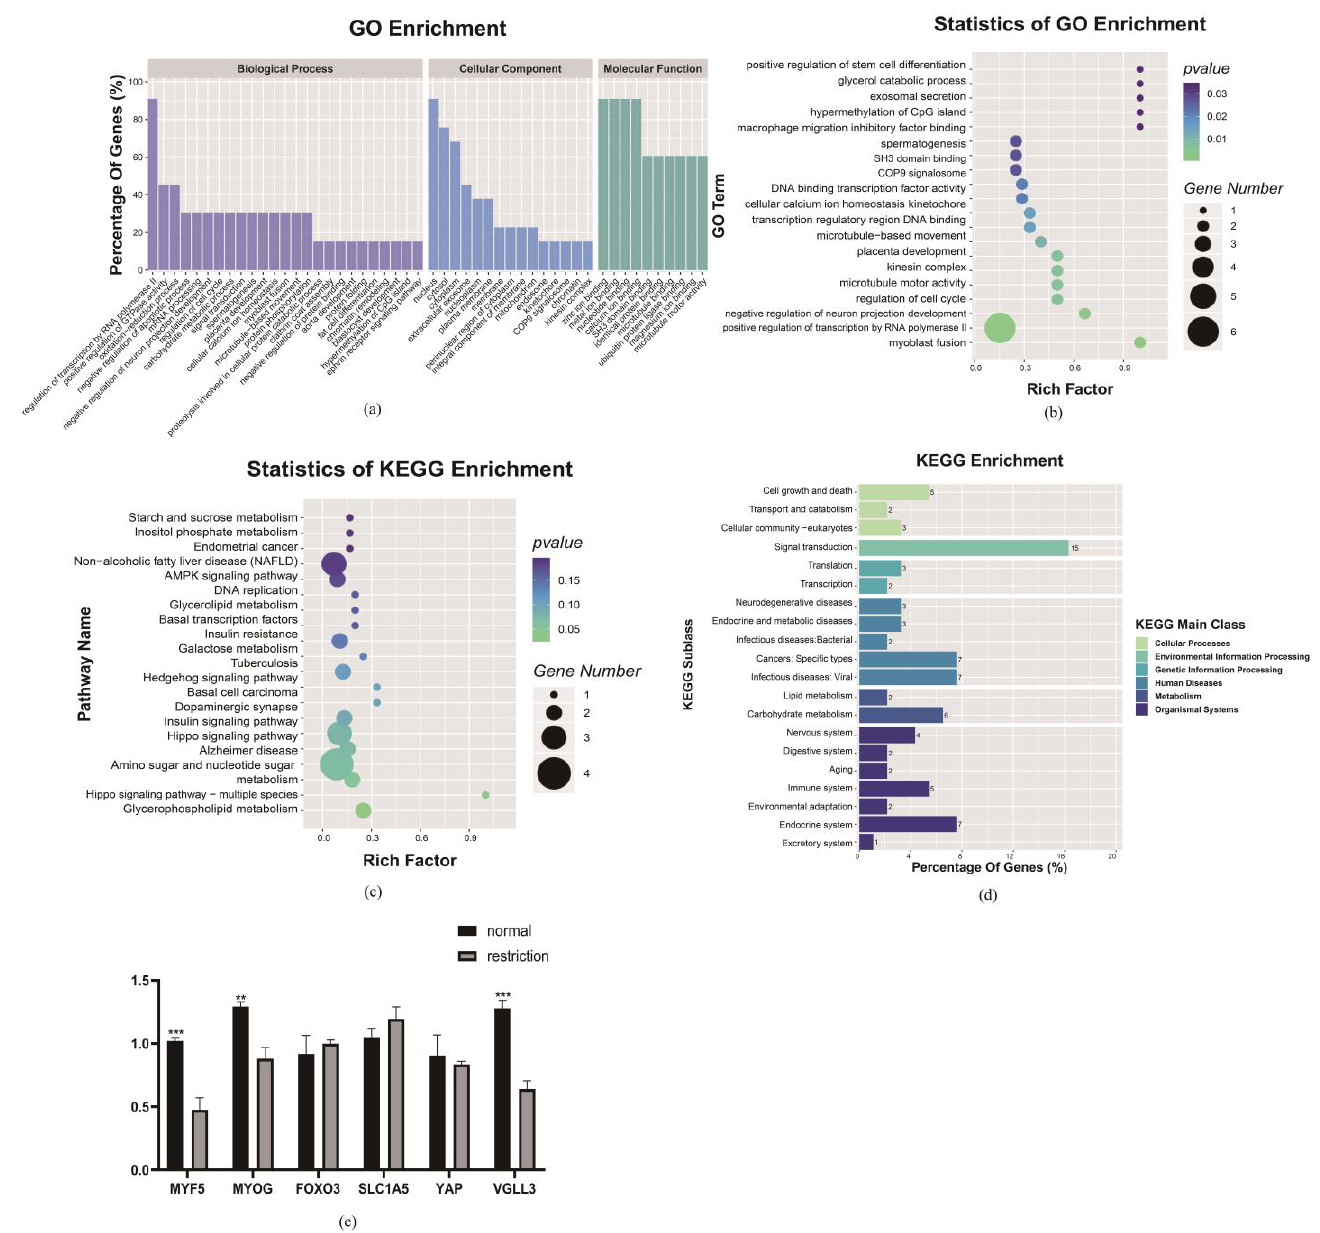
Figure 6. D135T vs. D135N differential expression mRNA-protein enrichment analysis and key candidate gene-related gene expression analysis. ( a ) Differential expression mRNA-protein Gene Ontology (GO) term analysis; mRNA-protein are classified into three main categories by the GO analysis, purple indicates the biological process, blue indicates the cellular component and green indicates the molecular function. ( b ) Differential expression mRNA-protein GO enrichment analysis. ( c ) Differential expression mRNA-protein KEGG analysis, in ( b , c ), the size and color of the bubble indicate the number and significant characters of the differentially expressed mRNA-proteins. ( d ) Differential expression mRNA-protein KEGG enrichment analysis, the orthologous signaling pathways are classified into different functions. ( e ) TEAD1 -related gene expression analysis, p < 0.01 (**) or p < 0.001 (***).